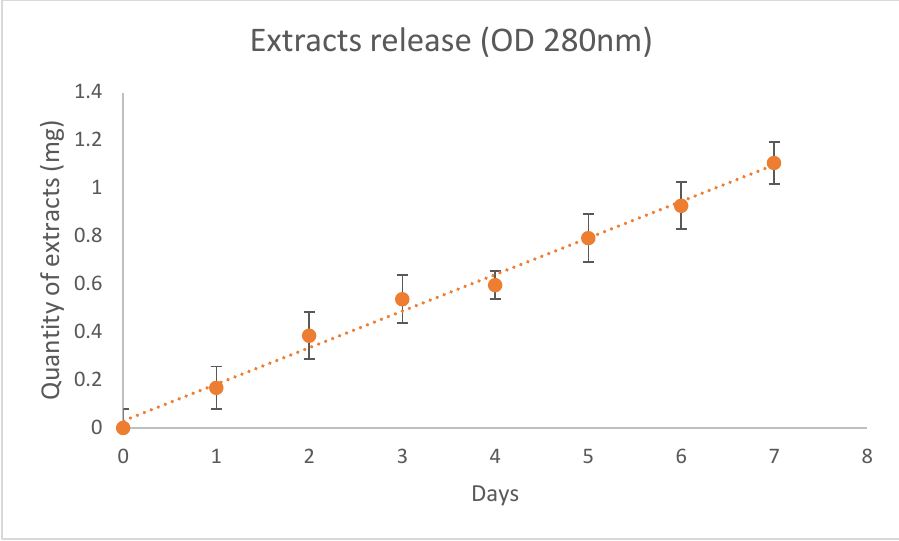
Figure 2. Release of myrtle extracts from NanoPCL-M for 7 days. The amount of extracts was evaluated as absorbance OD detected at 280 nm, and is expressed as mg of extracts/day.